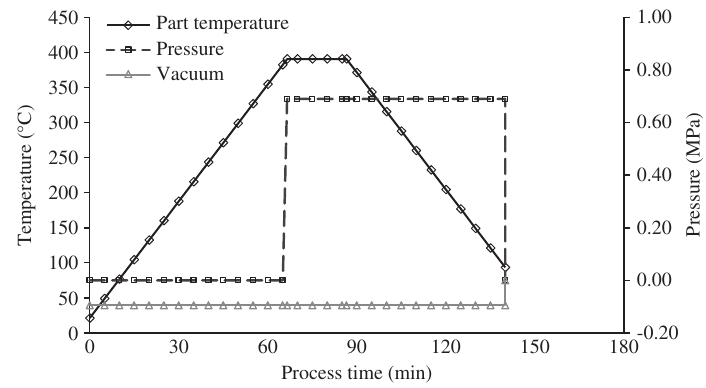
Figure 2: Processing cycle of APC-2/AS4.